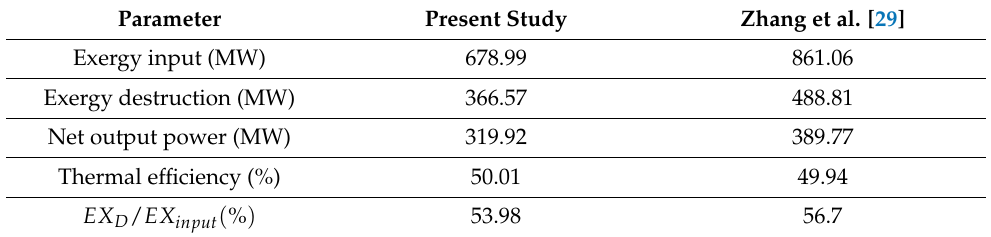
Table 4. Comparison between the obtained ISGC modelling results with those from Zhang et al. [29]. Parameter Present